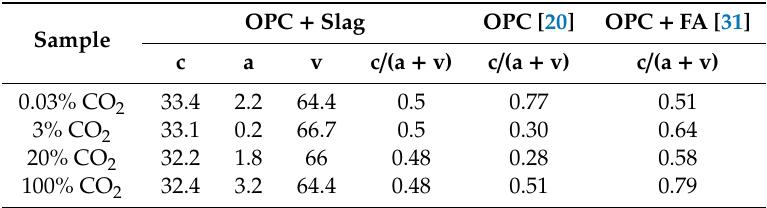
Table 2. Relative proportions of CaCO 3 polymorphs identified by TOPAS software (c = calcite; a = aragonite; v = vaterite). OPC + Slag OPC [20] OPC + FA [31] Sample